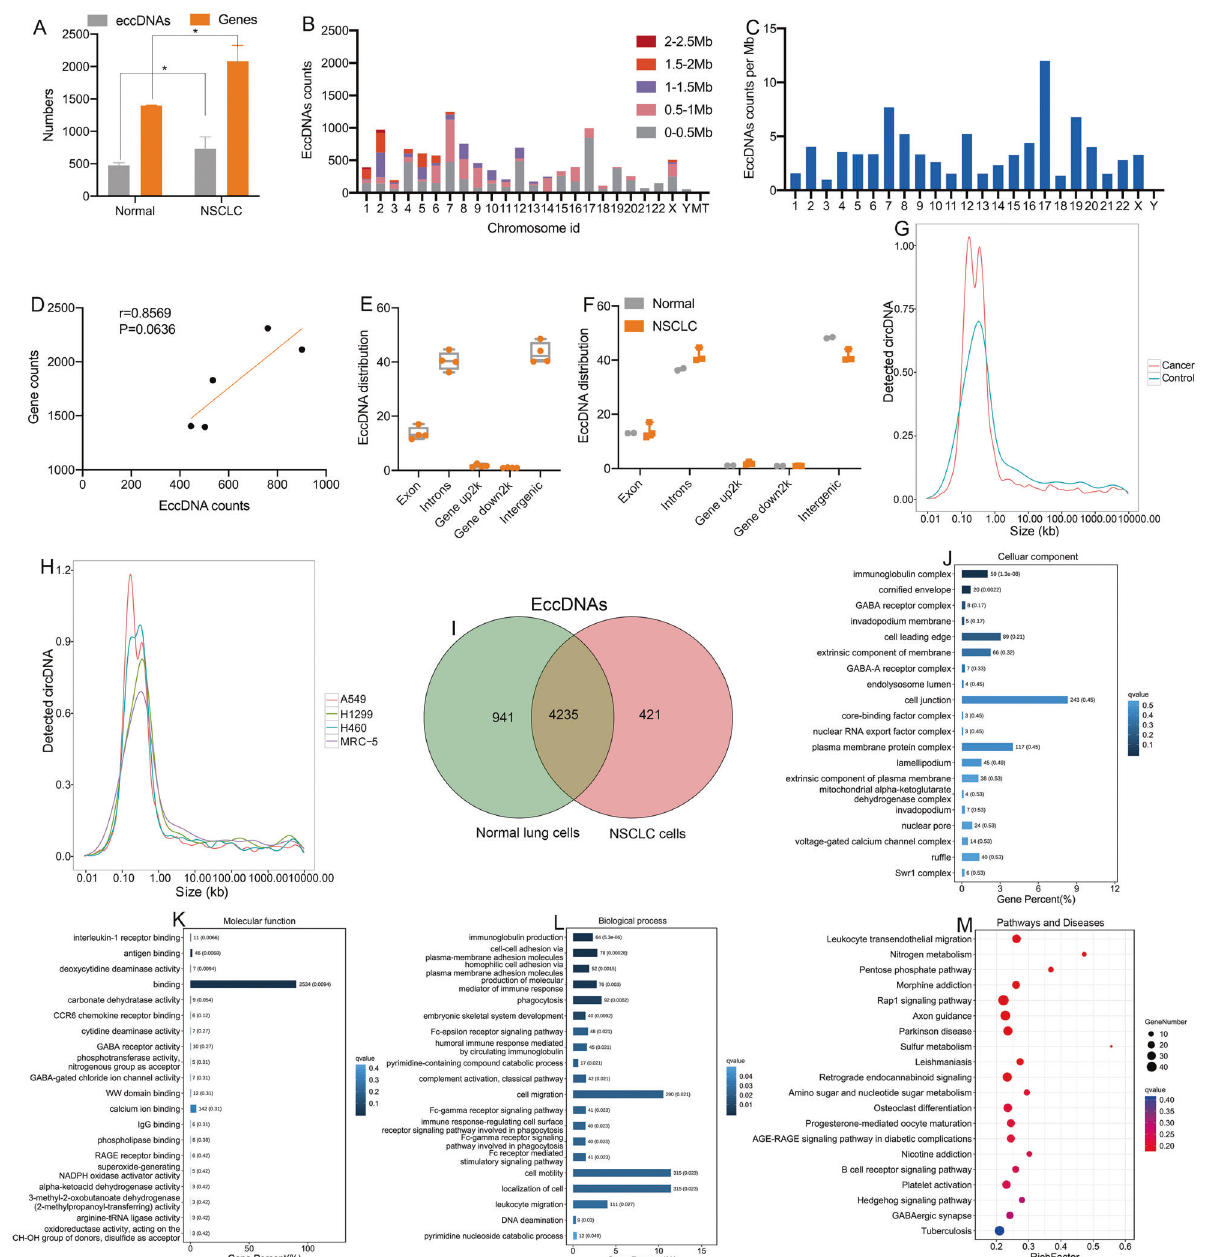
chromosomes. C The eccDNA frequency per Mb in each chromosome. D There was no signi fi cant correlation between the number of coding genes and eccDNAs in each chromosome ( P = 0.0636). E , F The distribution of eccDNAs in different classes of genomic regions. G , H The length distribution of eccDNA ranged from 0.01 kb to 1000 kb. I A Venn diagram showing the eccDNAs detected in NSCLC and normal lung cells. J – L The cellular components, molecular functions, and biological processes associated with the eccDNAs. M KEGG pathway analysis of the eccDNAs between NSCLC and normal lung cells. EccDNA extrachromosomal circular DNA, NSCLC non-small cell lung cancer, Mb